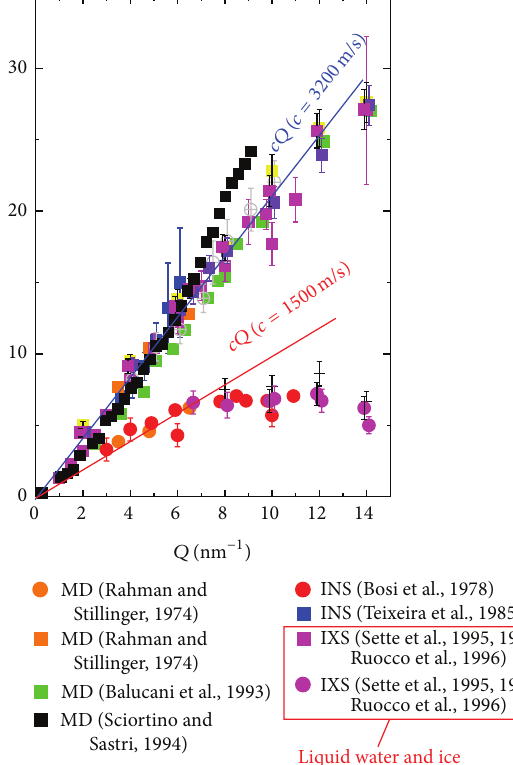
Figure 8: Sound dispersion curves of the high frequency (squares) and low frequency (circles) modes in the spectrum of water and ice as determined in the various experiments and simulations indicated in the